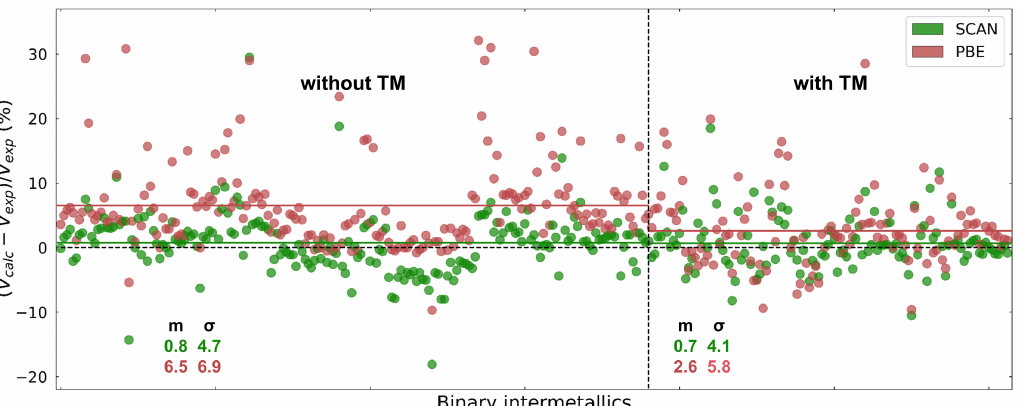
Figure 4. Deviations of the cell volume calculated within SCAN and PBE from experimental results for binary intermetallics with and without TM ions. The figure contains data for 191 alloys without TM ions [19] and for 116 alloys with TM ions [19,43,53,54,57,58]. The experimental values referenced in [19,43,53,54] are taken as the zero dash